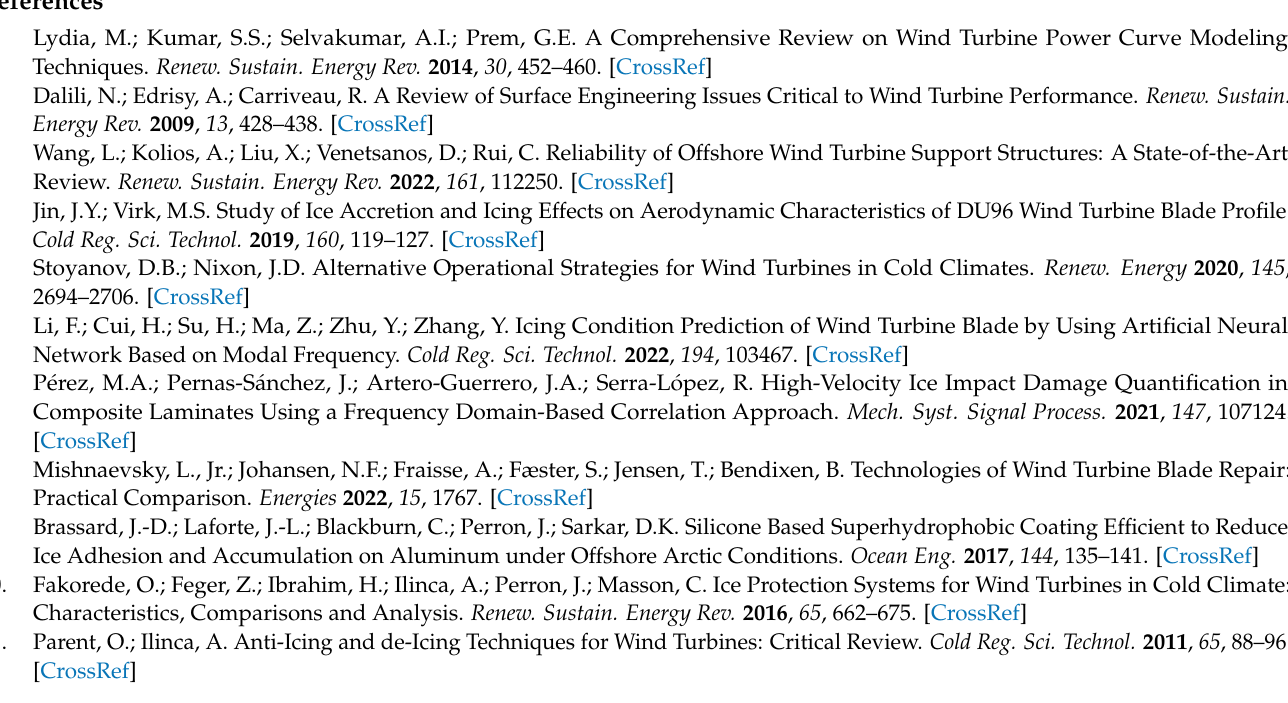
Figure S2: Adhesion test setup; Figure S3: Three-point bending test setup; Figure S4: Thermal imaging test setup; Figure S5: De-icing test: (a) ice formation in a − 15 ◦ C freezer (horizontal). De- icing (vertically positioned sample) at room temperature under 7.44 W power of: (b)